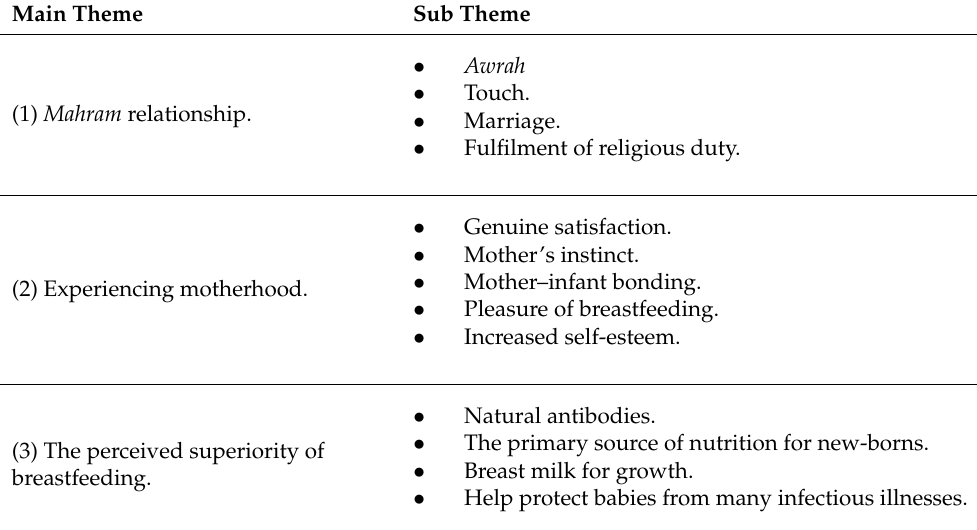
Table 3. Themes and sub-themes of the factors influencing women’s decisions about induced